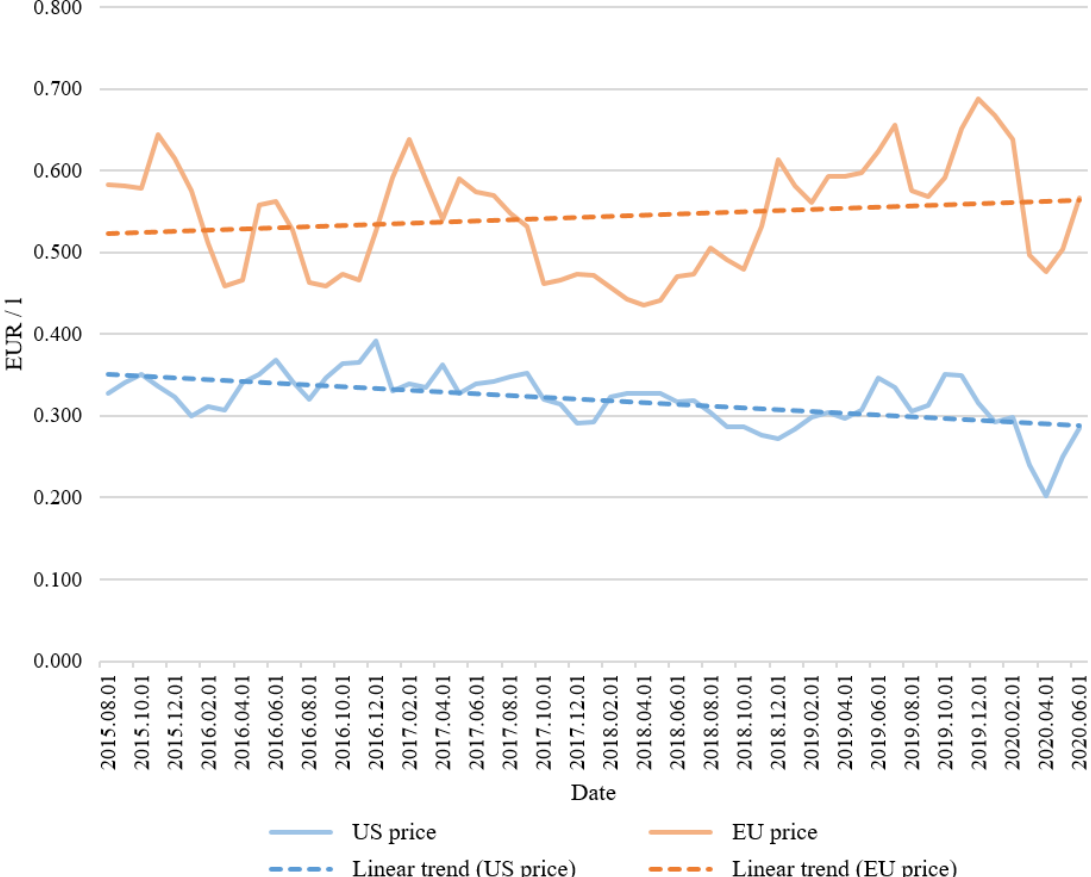
Figure 3. Ethanol prices in the US and EU. Source: [27]